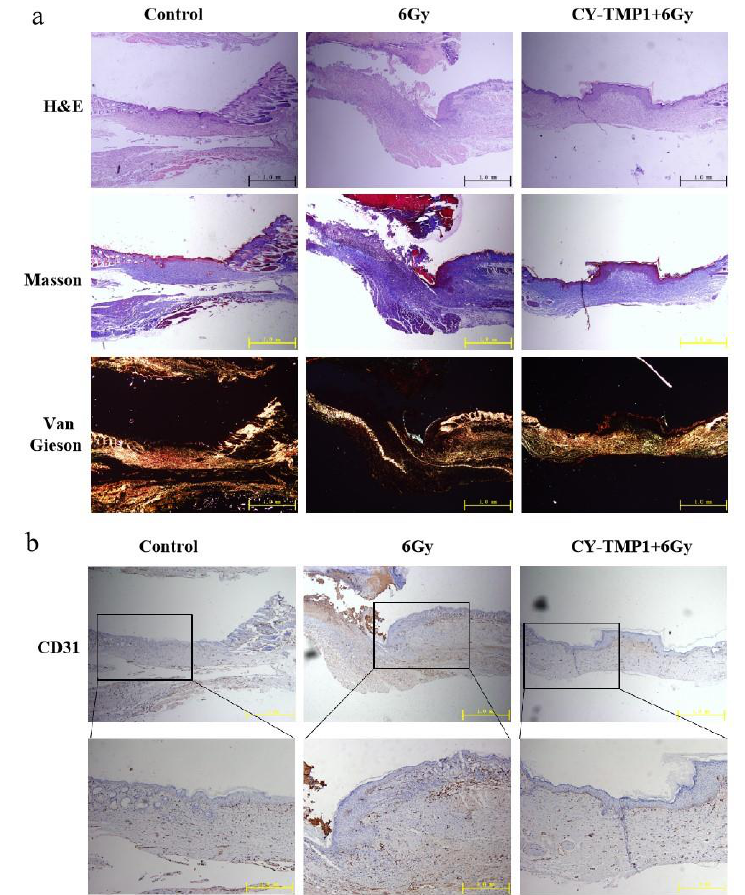
Figure 6. Histological analysis and immunofluorescence staining of wound sections at the end of observation (collected on the 13th day). ( a ) Representative photographs of wound sections with H&E, Masson and Van Gieson staining from three different groups; ( b ) Representative photographs of CD31 immunofluorescence staining of wound sections.